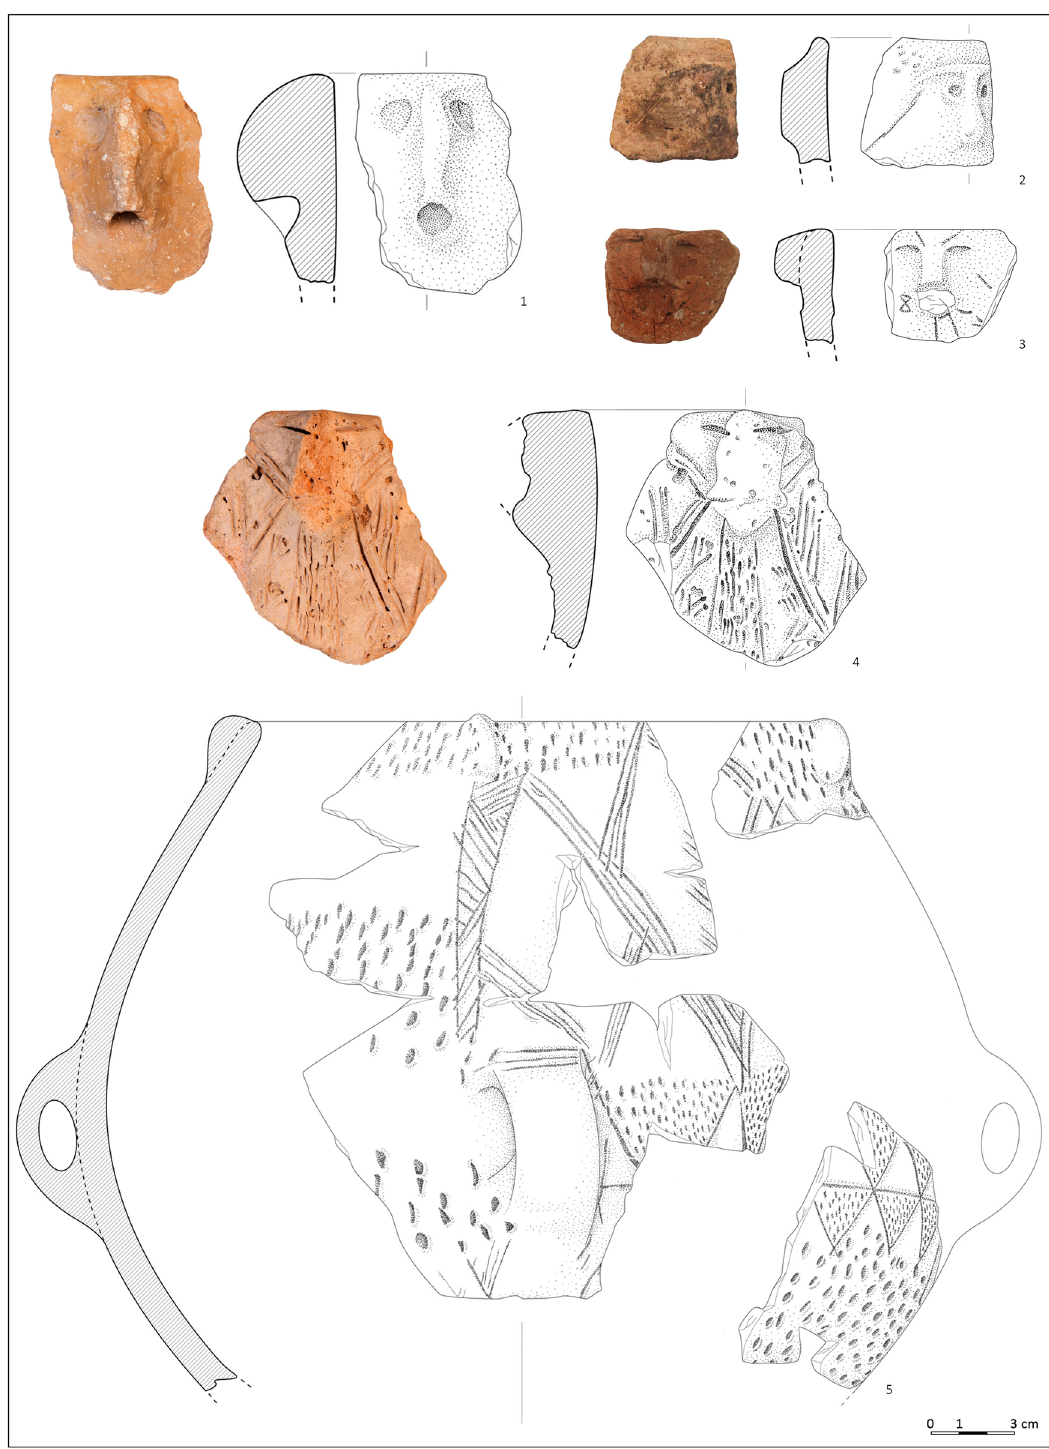
Figure 2: Vessels with human faces ( 1 – 2 – 3 ) and whole - body human fi gures ( 4 – 5 ) from Grotta dei